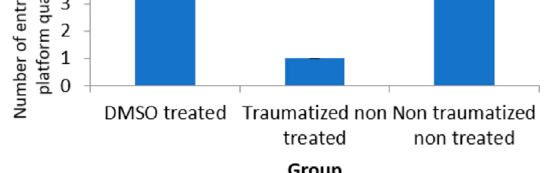
FIGURE 3 Effect of DMSO on locomotor activity in TBI induced